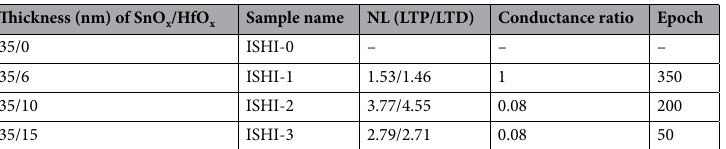
Table 1. Comparison of linearity at LTP and LTD, conductance ratio, and the number of stable epochs of different ITO/SnO x /HfO x /ITO/PEN